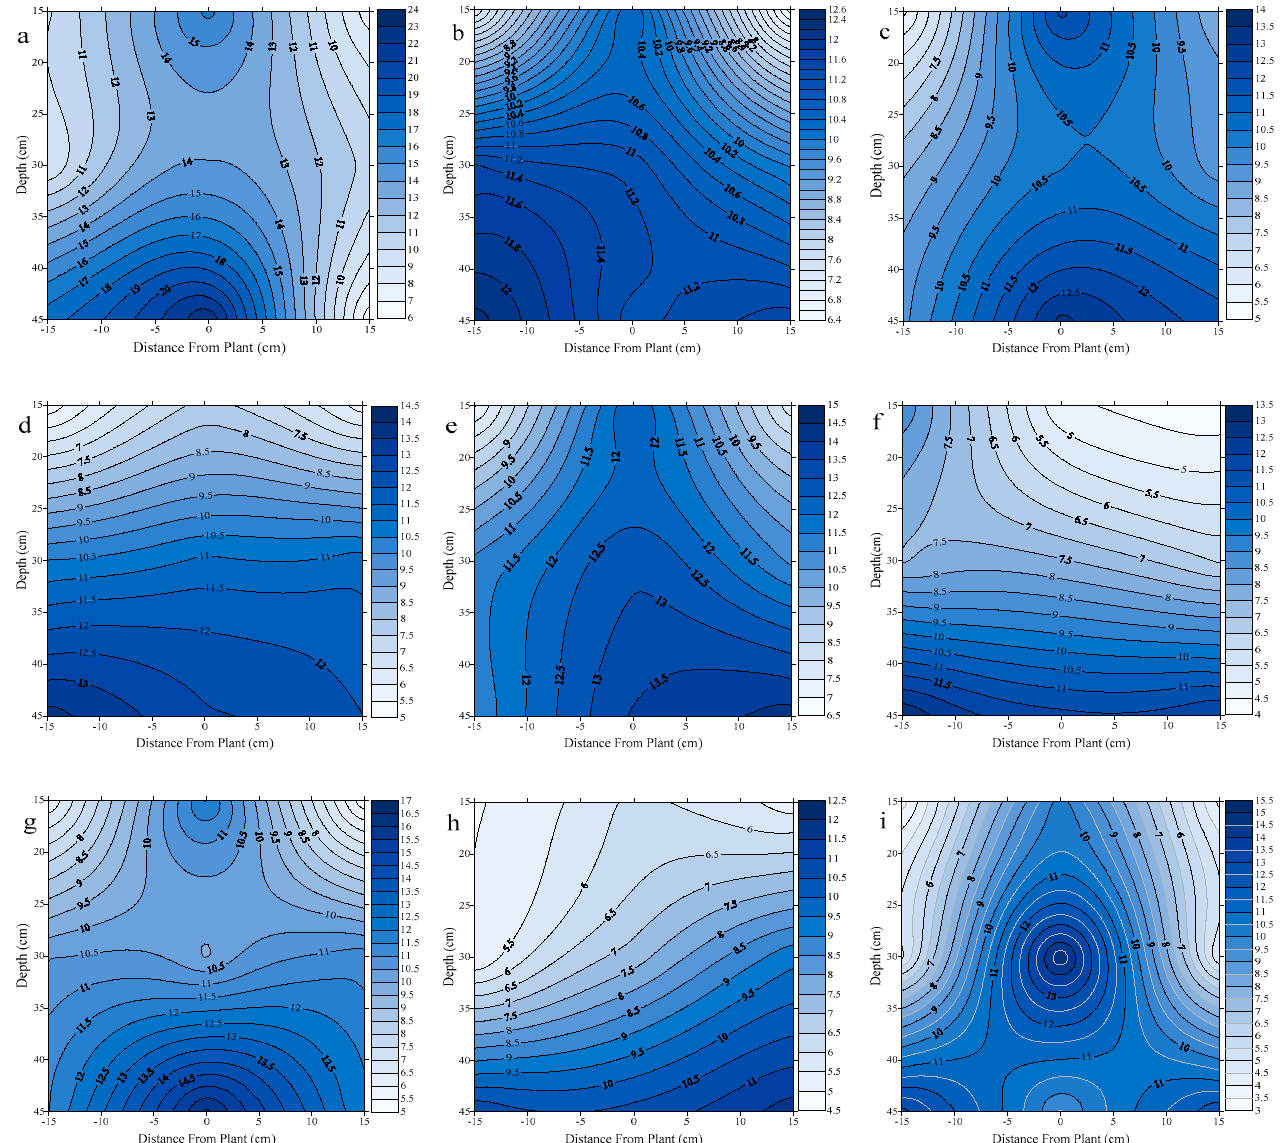
Figure 2. Soil moisture distribution after amending the soil with biochar and irrigating with saline water for ( a ) 100%, ( b ) 80%, ( c ) 60%, and ( d ) 40% ETc and under partial root drying for four stages, full irrigation treatment ( e ), ( f – h ) without biochar and ( g – i ) with biocahr under fresh